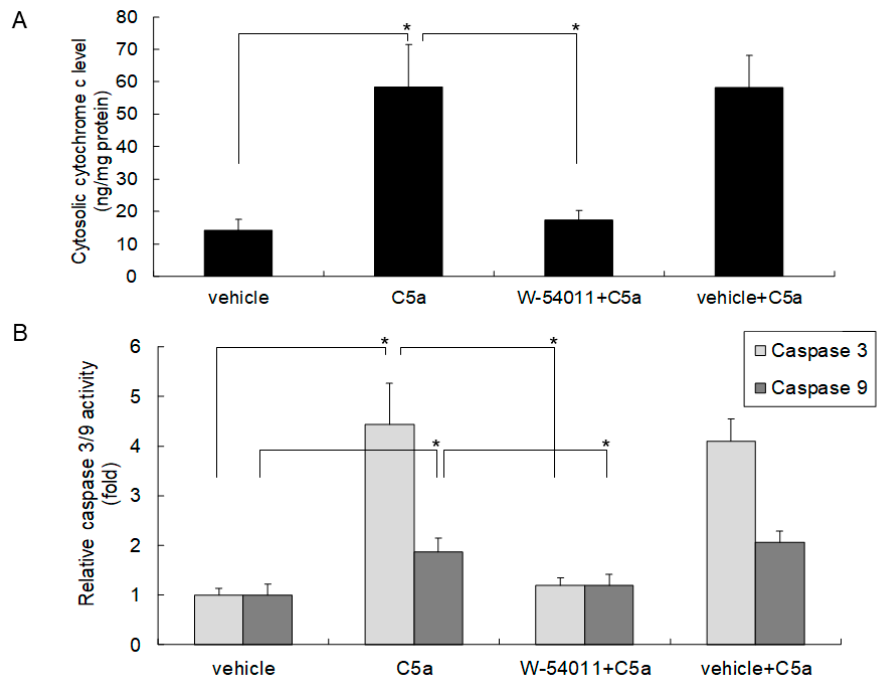
Figure 3. High-dose C5a treatment induced cytochrome c and caspase 3 / 9 activities through C5aR in mouse KECs. Mouse KECs were pretreated with the C5aR inhibitor (W-54011; 10 µ g / mL) or vehicle (Dimethyl sulfoxide (DMSO); 0.1%) for 1 h prior to 50 ng / mL of rmC5a treatment. After 48 h, cytosolic protein was purified for ( A ) cytochrome c and ( B ) caspase 3 / 9 activities by ELISA. The data are represented as mean ± SD. * p < 0.05.